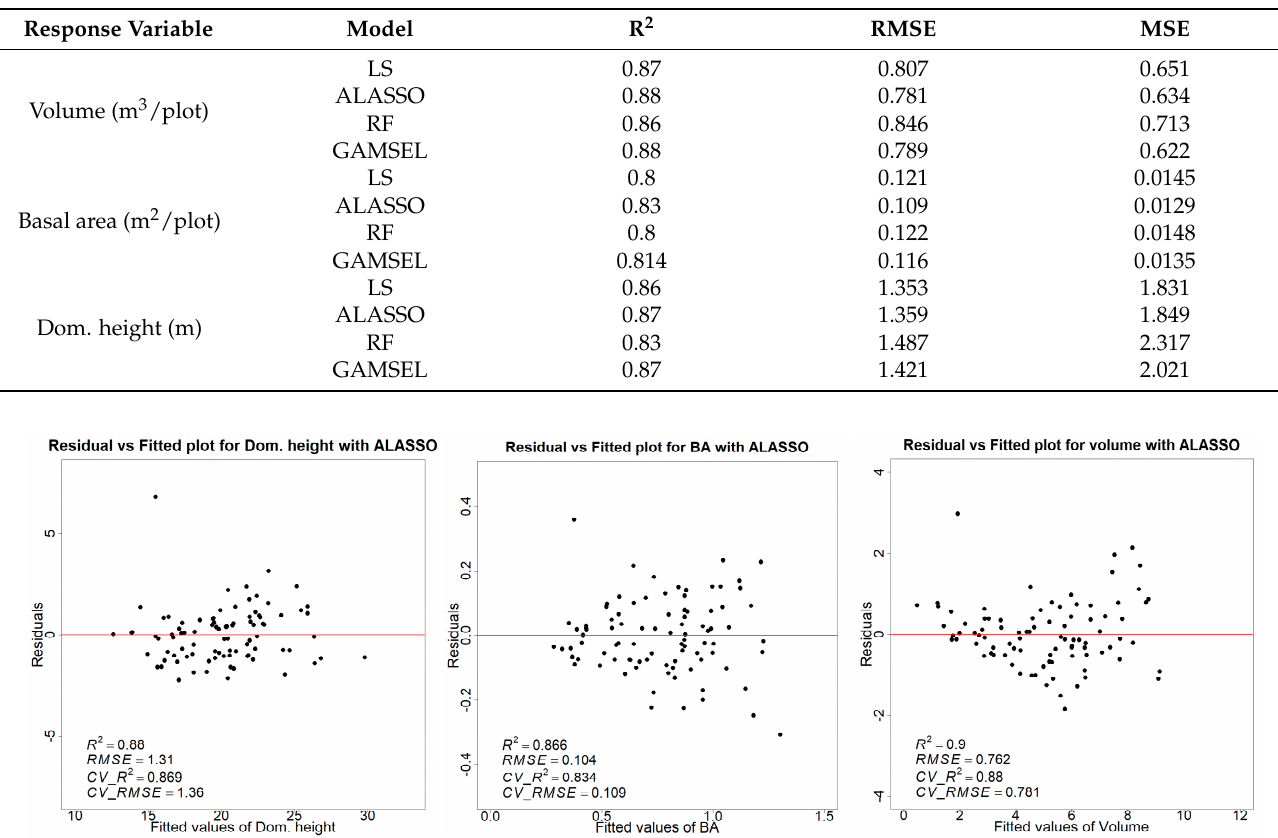
Table 7. K-fold cross-validation result summary for all response variables with four different model- ing methods.